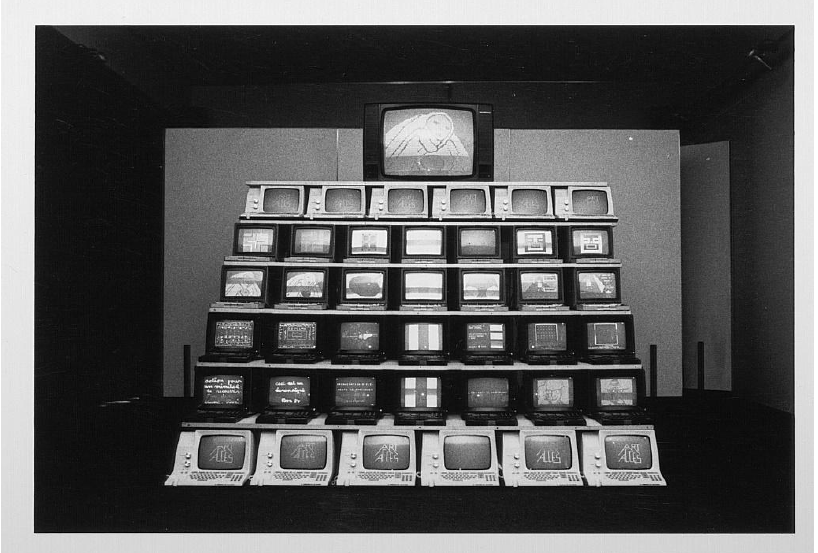
Figure 10. Installation of Art Accès at the Locarno International Video Festival in 1985. Collection Frédéric Develay © Kandinsky Library, MNAM/CCI, Centre Pompidou.